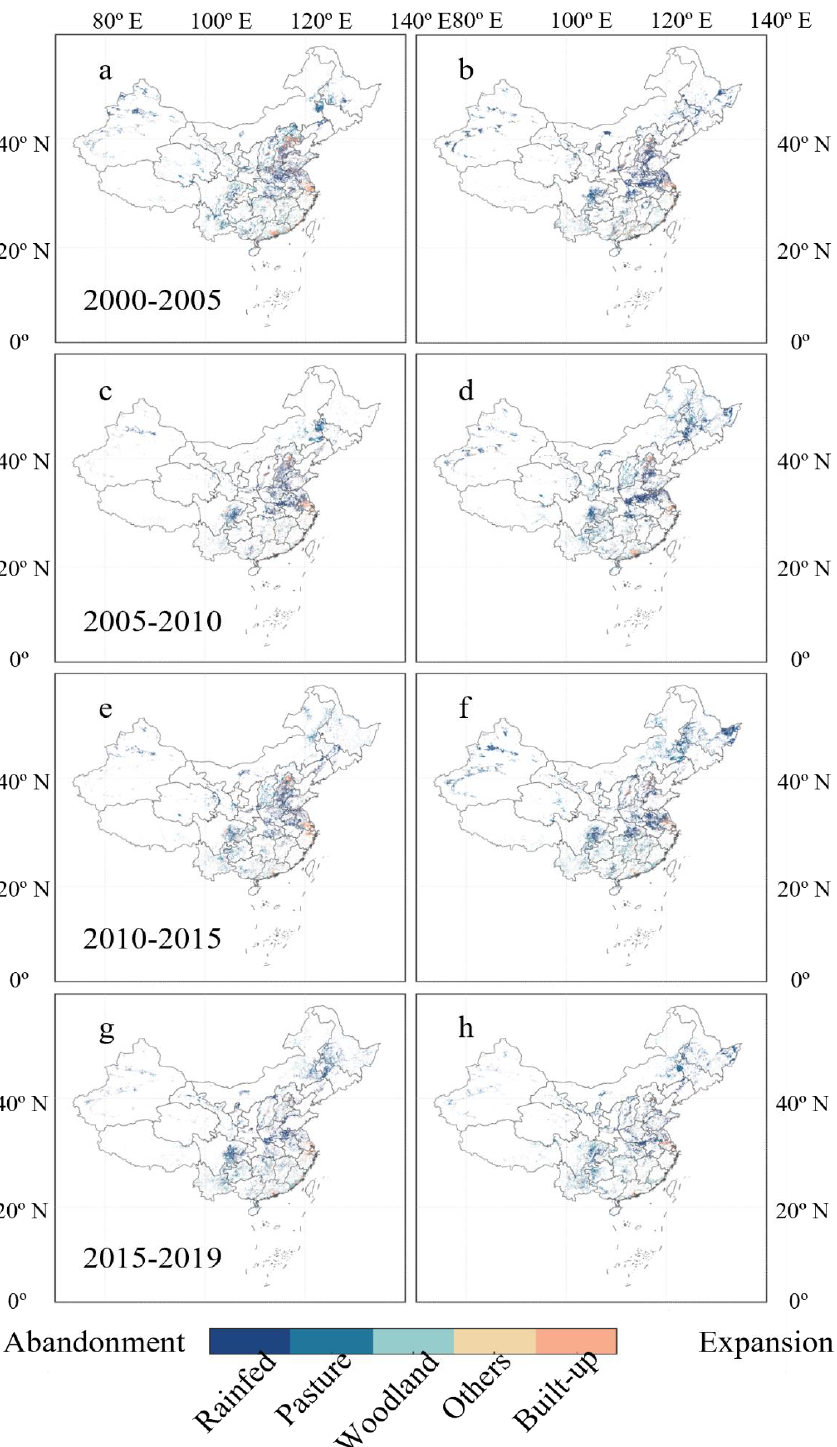
Figure 9. Spatial distributions of land-use transitions caused by irrigated cropland changes during 2000–2019: land-use transitions led by irrigated cropland abandonment ( a – g ) and expansion ( b – h ) in 5-year